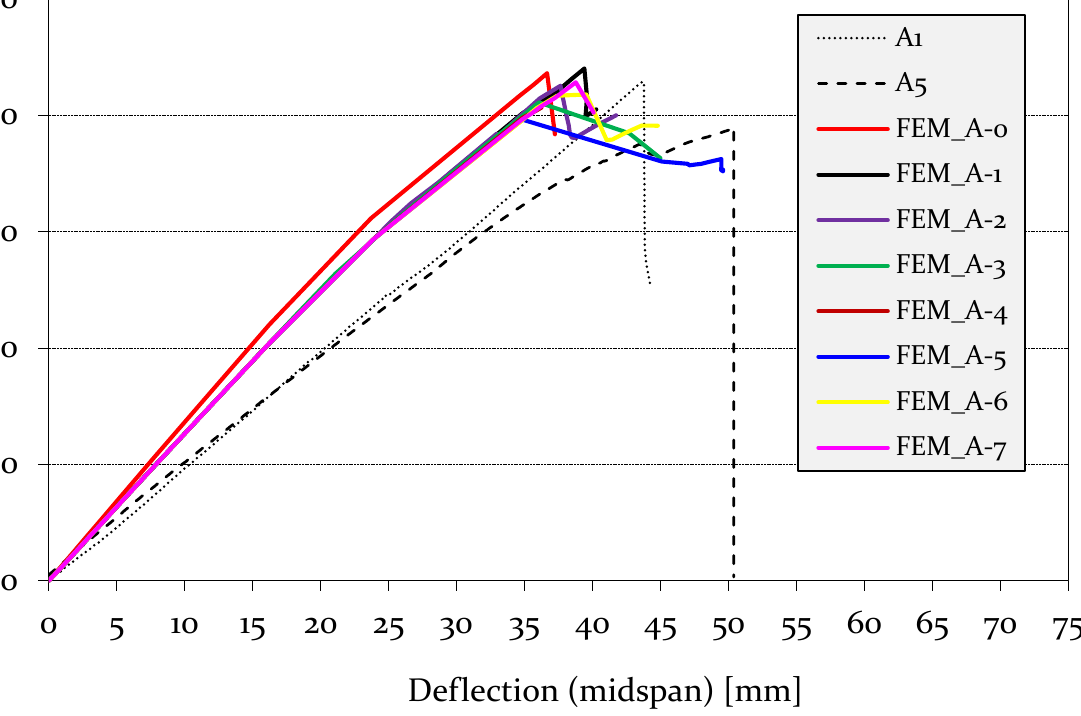
Figure 10. Comparison of bending load–displacement relationship between FEM and experimental test of unreinforced timber beam.